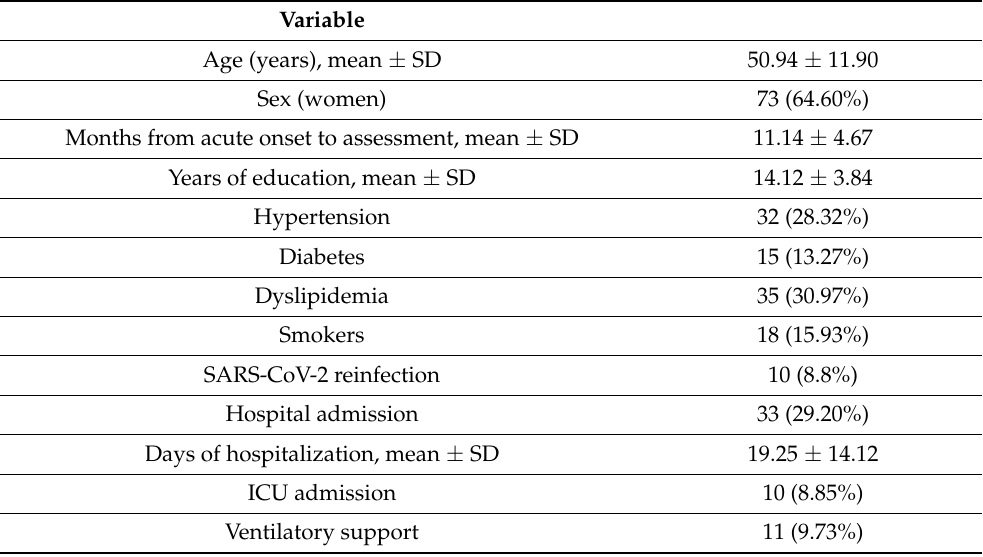
Table 1. Main demographic and clinical